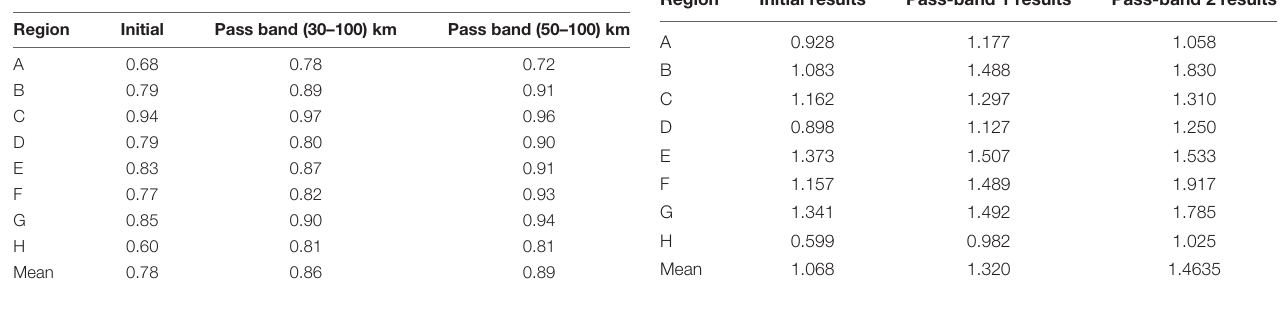
TABLE 4 | Correlations between shipborne depths and gravity anomalies in each region.